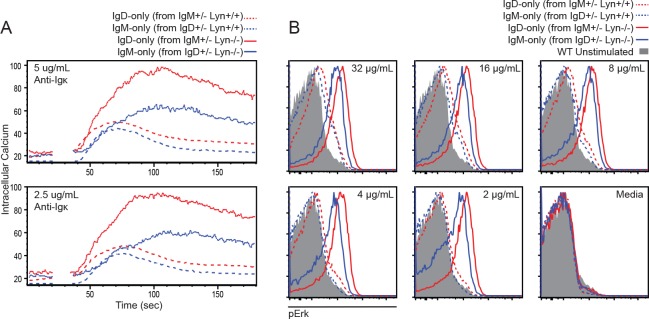
Signaling in IgM+/− and IgD+/− Lyn−/− B cells.(A) Splenocytes from IgM+/− and IgD+/− mice on either Lyn+/+ or Lyn−/− backgrounds were loaded with Indo-1 and stimulated with anti-Igκ. WT (IgMb+) B cells were gated out to isolate IgM-null (IgD-only) and IgD-null (IgM-only) cells. CD19+CD23+ B cells are compared. (B) Intracellular Erk phosphorylation in splenic B220+CD23+ B cells from mice in (A) stimulated with varying doses of anti-Igκ for 5 min. Shaded histogram corresponds to IgMb+ cells from IgD+/− Lyn−/− mice incubated with medium alone for reference. (A) and (B) are representative of two independent experiments.